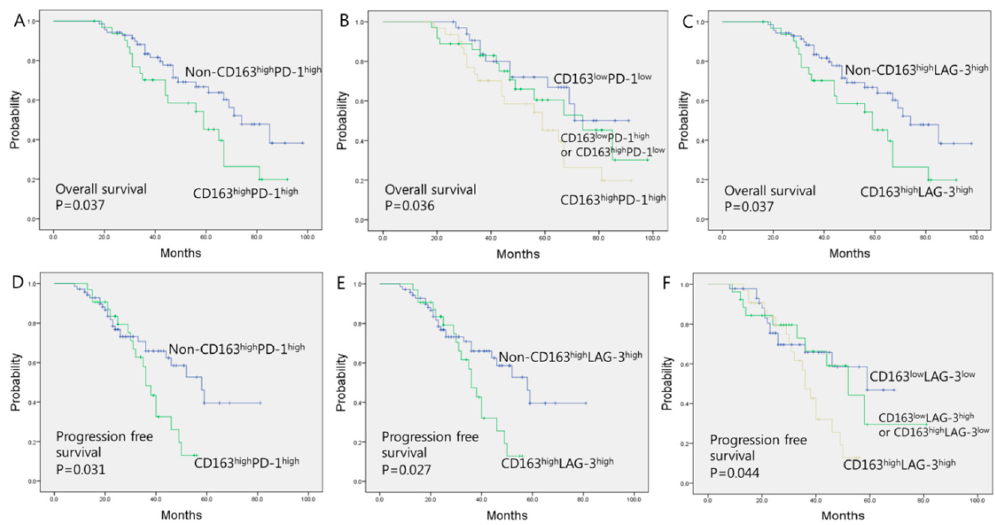
Figure 2. Patient survival outcome according to expression of CD163, PD-1, and LAG-3 in cutaneous melanoma. ( A ) OS according to high expression of both CD163 and PD-1. (Hazard ratio (HR); 2.08, 95%CI; 1.14-5.57). ( B ) Worse OS in patients with high expression of both CD163 and PD-1. ( C ) OS according to high expression of both CD163 and LAG-3. (HR; 1.88, 95%CI; 1.16–5.87). ( D ) PFS according to high expression of both CD163 and PD-1. (HR; 1.76, 95%CI; 1.08–5.46). ( E ) PFS according to high expression of both CD163 and LAG-3. (HR; 1.54, 95%CI; 1.07–5.13). ( F ) Worse PFS in patients with high expression of both CD163 and LAG-3. A sample was considered to show high expression for CD163 if the positive cells constituted ≥ 35% of the overall cellularity. A sample was considered to show high PD-1 and LAG-3 expression if ≥ 20% of the tumor infiltrating inflammatory cells. Survival analyses were performed using the Kaplan–Meier method with the log-rank test. Multivariate analyses were performed using a Cox proportional-hazards regression model. Table 3. Survival outcomes of 102 patients with cutaneous melanoma according to CD163, PD-1, and LAG-3